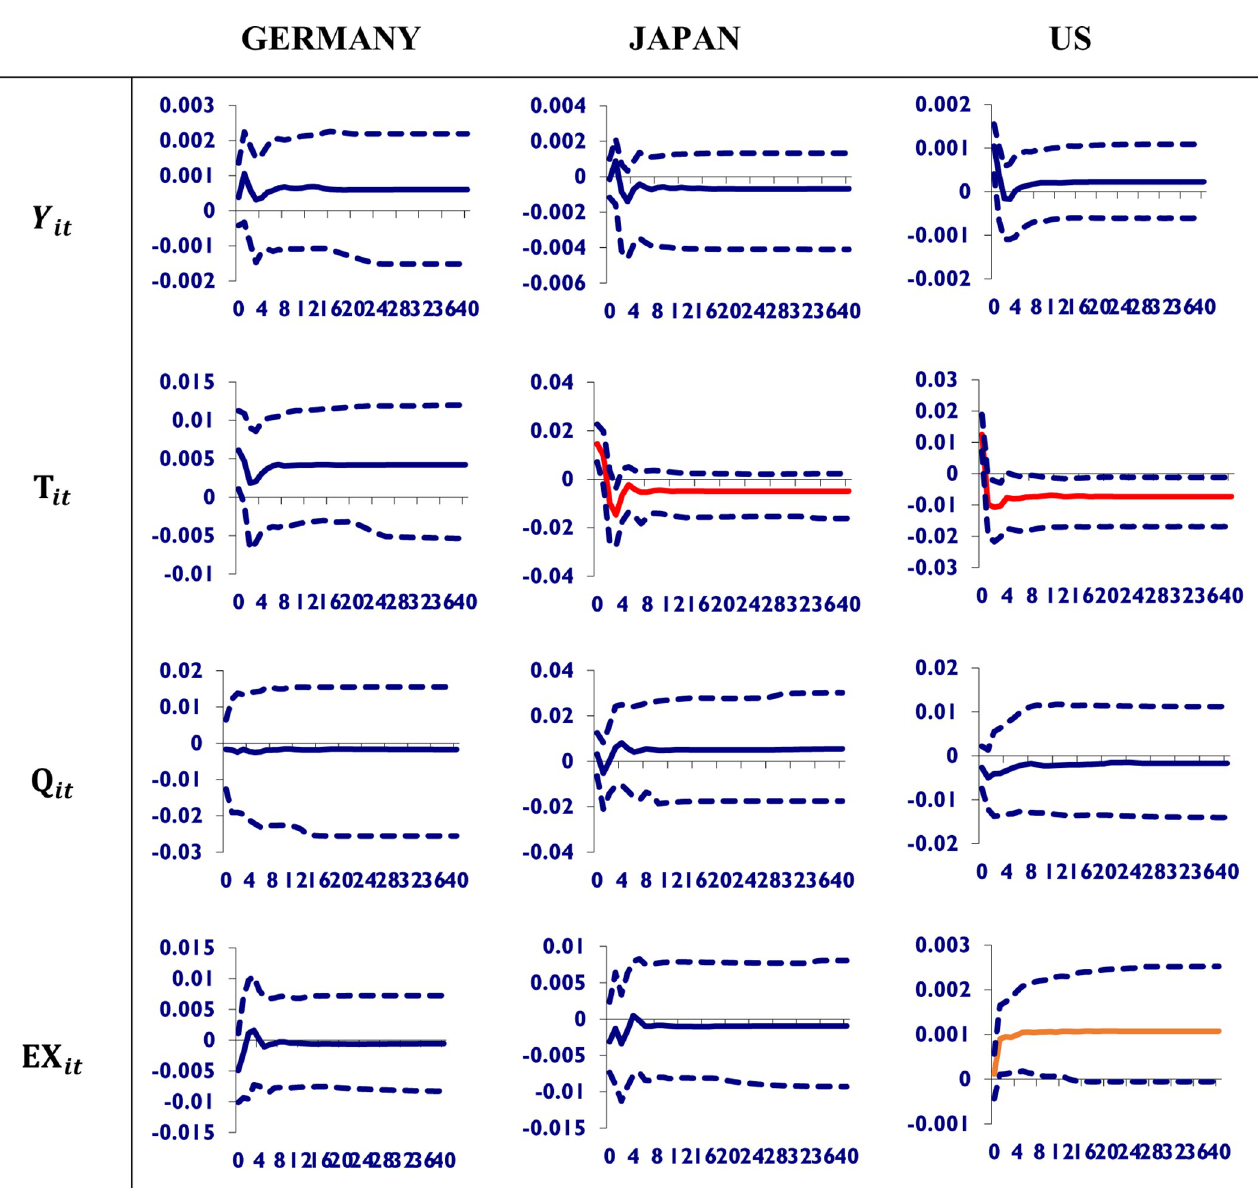
Fig 3. Shocks to Chinese trade volume and its impact on its trading partners economies. A shock to Chinese trade volume has a little bit improved the GDP and total trade volume of Germany and has had an insignificant impact on its currency and its stock prices. It deteriorates Japan’s GDP and total trade volume. Whereas the US is more vulnerable to shocks from Chinese trade because it decreases its trade volume and depreciates its currency permanently, Germany’s economy is resilient to the trade shock from